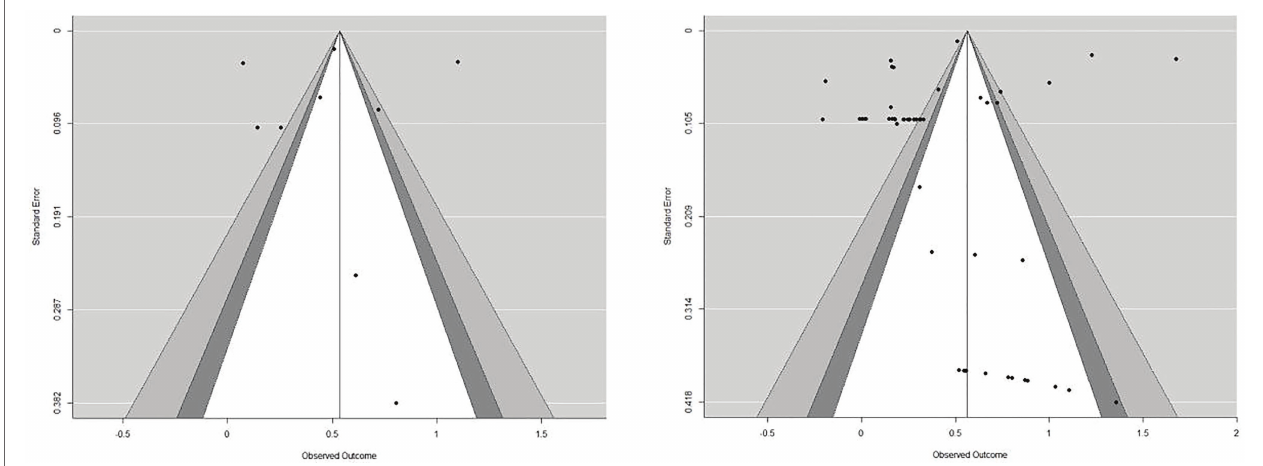
FIGURE 2 | Funnel plot for publication bias. We plotted independent effect sizes ( n = 9 from 6 studies) in the left plot and plotted all effect sizes (some dependent of each other) in the right